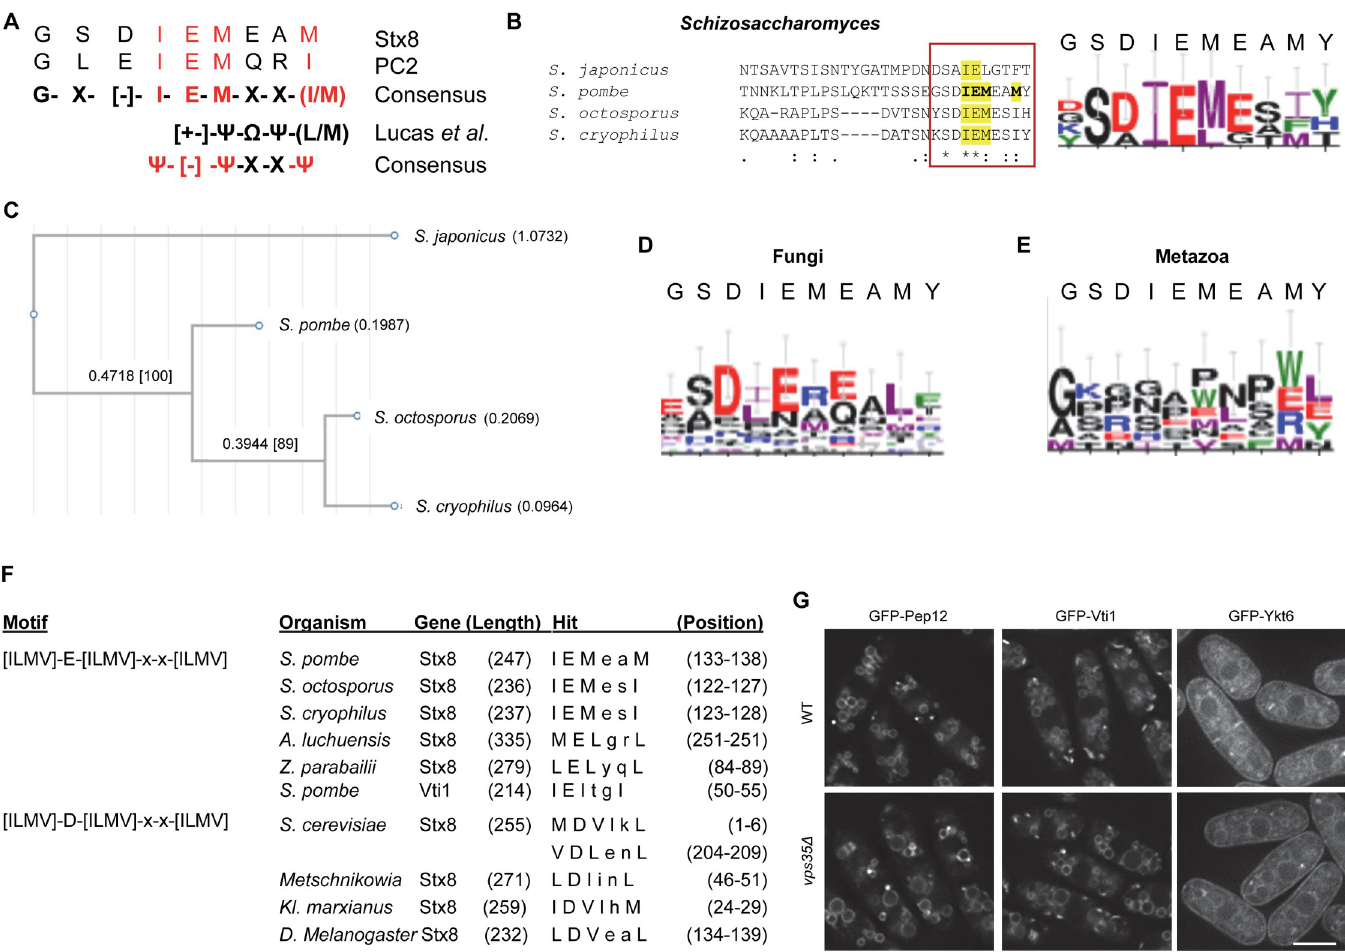
Fig 8. Conservation of the Stx8 IEMeaM motif. (A) Comparison between the motifs in Schizosaccharomyces pombe Stx8 and human PC2, and the consensus motif defined by Lucas et al [26] where C was hydrophobic residue with large aliphatic chain; [+-] a charged residue; and O a bulky hydrophobic (aromatic) residue [26]. In the case of Stx8 and PC2, where the charged residue is an E, the consensus at this position is [–]. The residues essential for function are in red font. (B) Left panel: BLASTP alignment of Fsv1/Stx8 proteins from the Schizosaccharomyces species. The square denotes the region where the IEMeaM motif is located. Right panel: Weblogo showing the conservation of the residues denoted by the square in the left panel. The S . pombe sequence is indicated at the top. E, D in red; H, K, and R in blue; F, Y, and W in green; and I, L, M, and V in purple. (C) Phylogram of the Fsv1/Stx8 sequences aligned with clustal W (B). (D) The same details as in (B), but the analysis was extended to 19 fungal Stx8 sequences. (E) The same details as in (B), but the Weblogo was deduced from the S . pombe , Homo sapiens , Pan troglodytes , Rattus norvegicus , Mus musculus , Danio rerio , Drosophila Melanogaster , and Arabidopsis thaliana Syntaxin 8 sequences. (F) ScanProsite hits detected by scanning for the indicated motifs. (G) Localization of the indicated SNAREs in WT and vps35 Δ